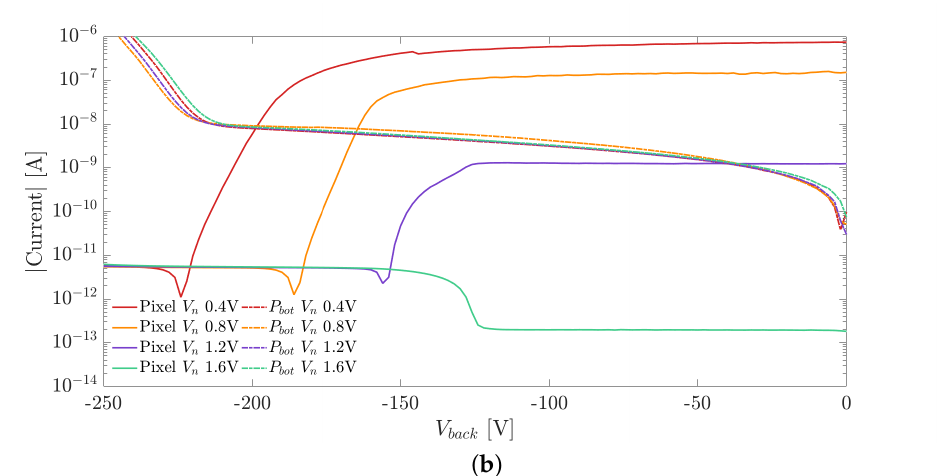
Figure 10. ( a ) Pixel nwell and backside p + implant I–V curves as a function of V n for a substrate thickness of 100 µ m. ( b ) Pixel nwell and backside p + implant I–V curves as a function of V n for a substrate thickness of 300 µ m.